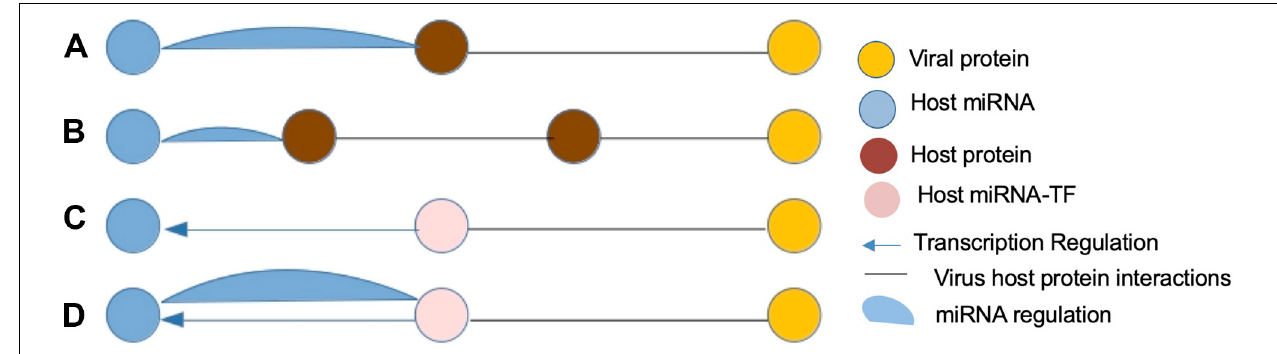
FIGURE 1 | Four most anticipated patterns of host miRNA-mediated virus–host interactions (FFLs). (A) A viral protein and human miRNA have common human target. (B) A viral protein and human miRNA have a protein pair as common target. (C) A viral protein targeting a TF of a human miRNA. (D) A viral protein targeting a host protein forming a feedback loop to a human